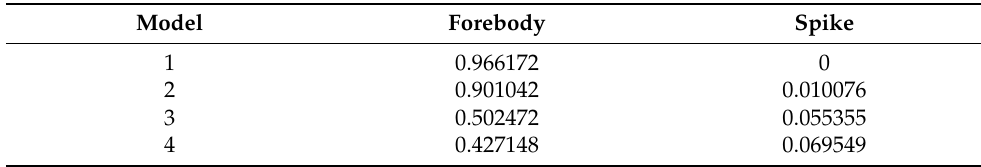
Table 7. Influence of the spike and forebody on drag coefficient.